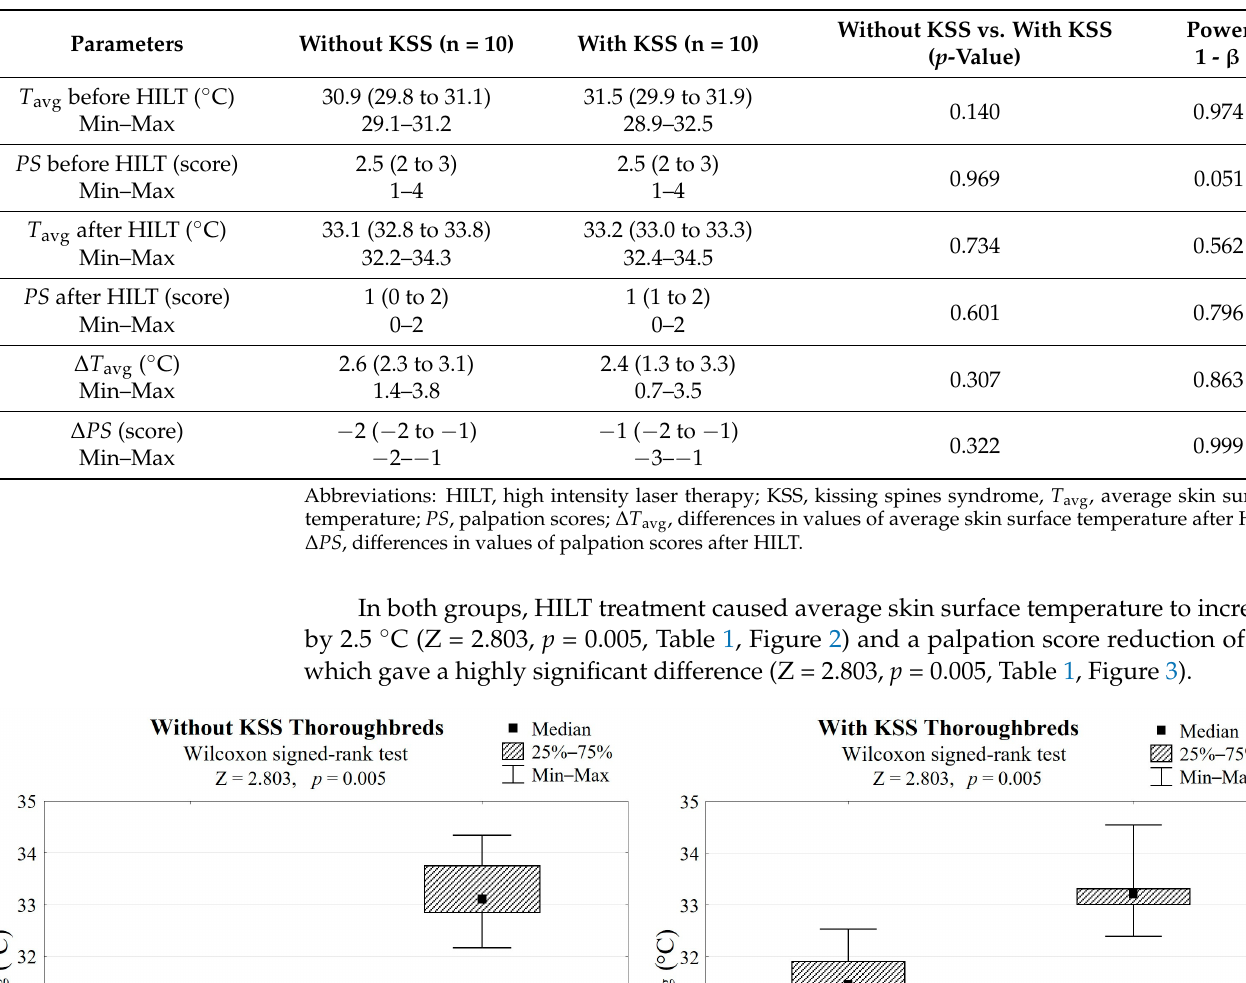
Table 1. Skin surface temperature, palpation score and differences in skin surface temperature and palpation score (median and IQR) before and after HILT treatment for horses diagnosed with and without KSS.